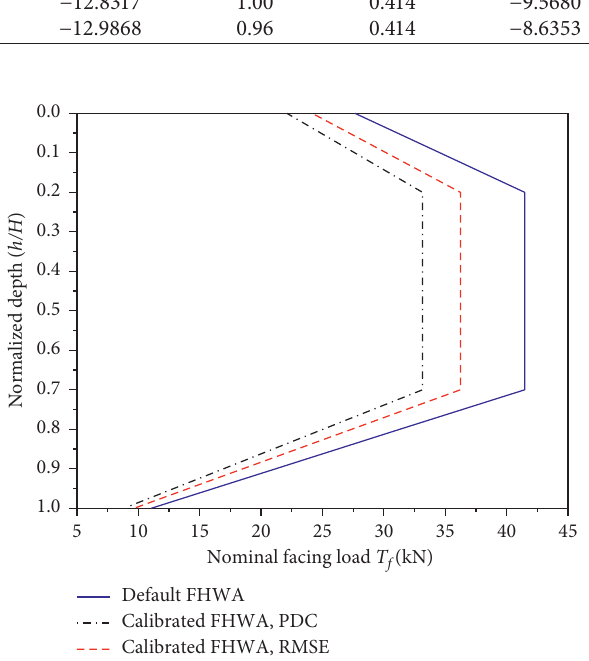
Figure 6: Predicted (nominal) maximum facing loads along depth using the three FHWA